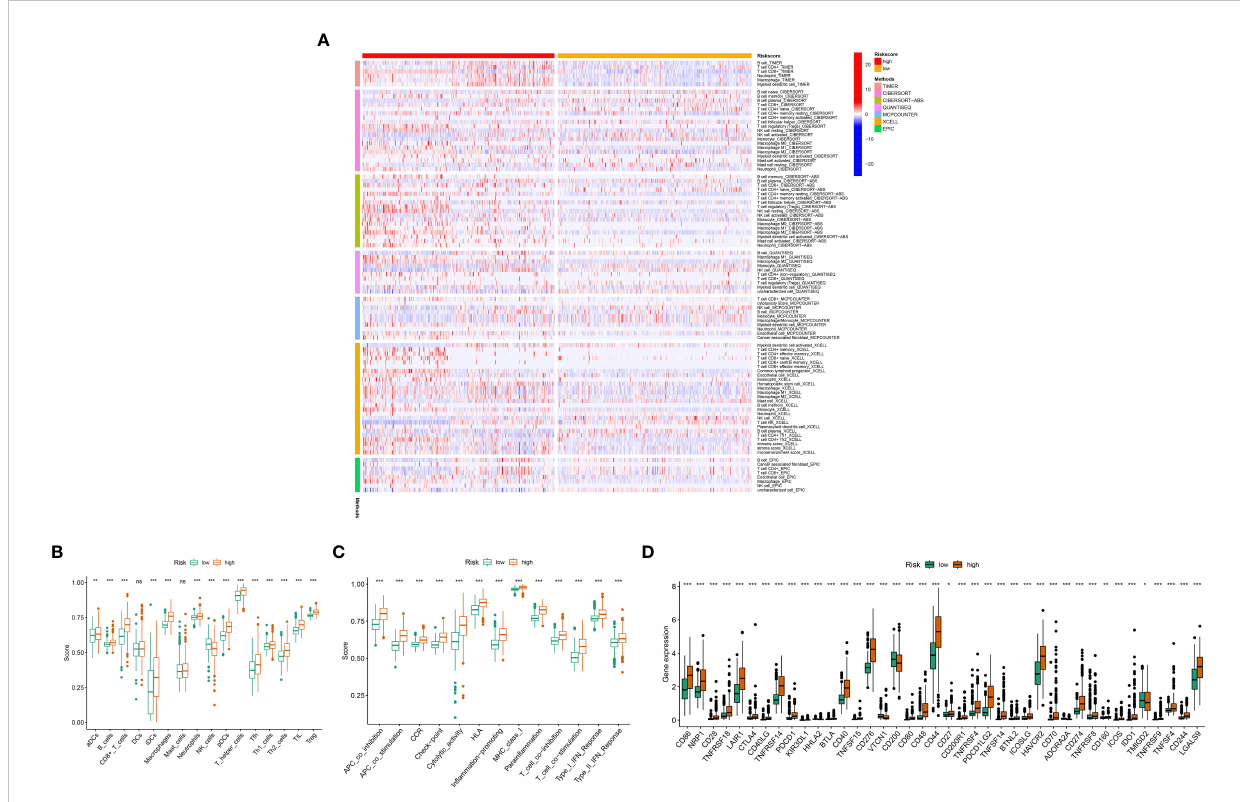
FIGURE 8 Relationship between mitochondria-associated differential gene prognostic models and immune cell in fi ltration: (A) Heat map of immune responses in high and low risk groups based on CIBERSORT, CIBERSORT-ABS, XCELL, MCPcounter, QUANTISEQ, EPIC and TIMER algorithms. (B) High- and low-risk groups with immune cell scores; (C) High- and low-risk group populations with immune-related functions. (D) Immune checkpoint expression in high and low risk groups. P values (*P < 0.05; **P < 0.01; ***P < 0.001). ns, not statistically signi fi